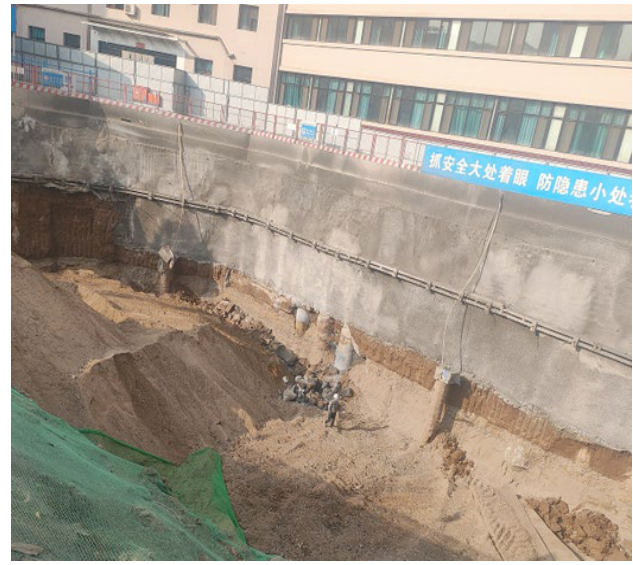
Figure 7. Tubewell lowering diagram.